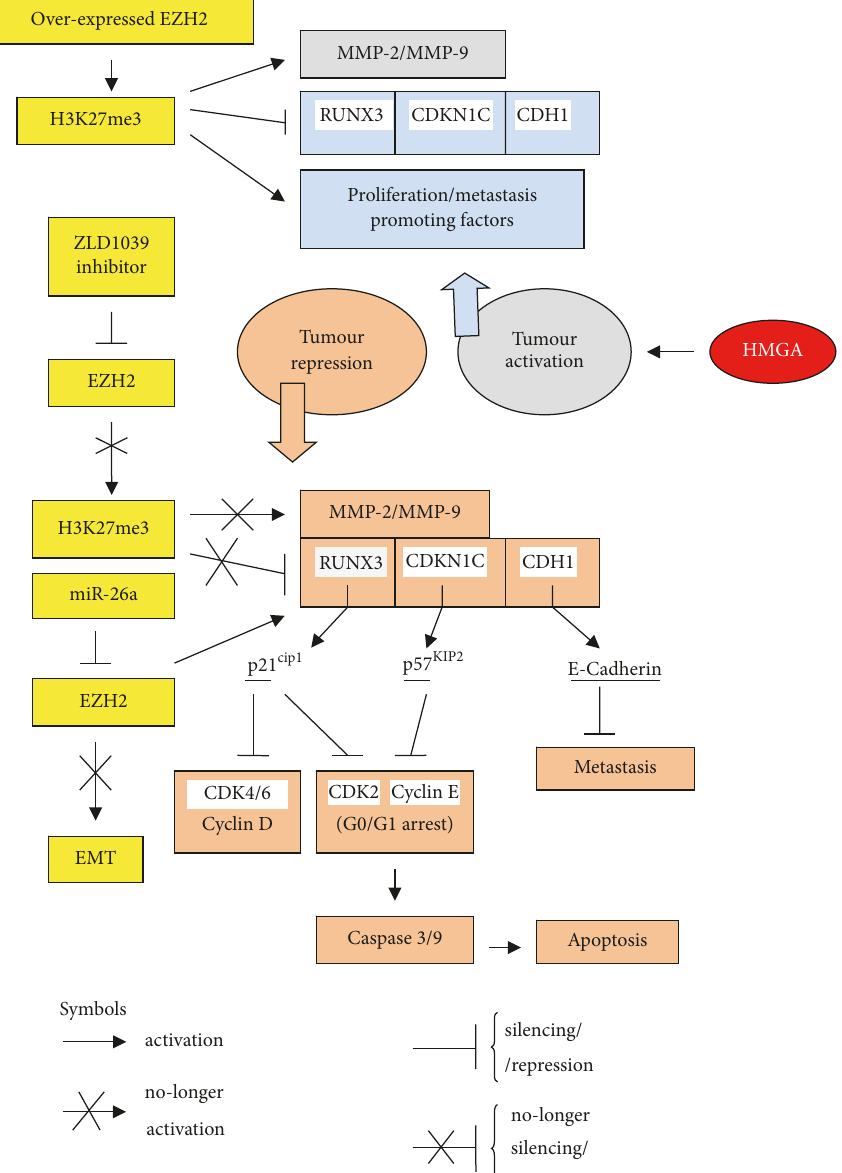
Figure 1: Alternative cascades of events following EZH2 overexpression/repression in cancer cells. CDH: cadherin; CDK: cyclin-dependent kinase; CDKN1C: cyclin-CDK inhibitor p57; EMT: epithelial-mesenchymal-transition; EZH2: enhancer of zeste 2; MMP: metalloprotease; p 21 cip 1 : p21 CDK-interacting protein 1; p 57 KIP 2 : p57 kinase inhibitory protein 2; RUNX3: runt-domain transcription factor 3.